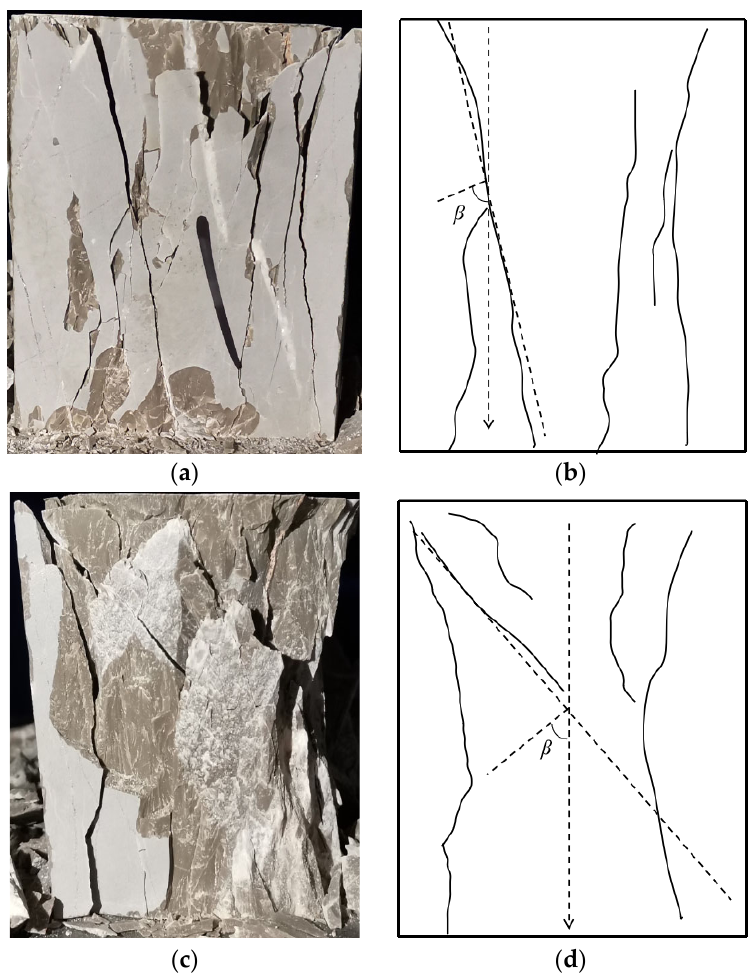
Figure 5. The failure modes of the two kinds rock samples: ( a ) the failure mode of ATWR; ( b ) the crushing plane of ATWR; ( c ) the failure mode of NR; ( d ) the crushing plane of NR.